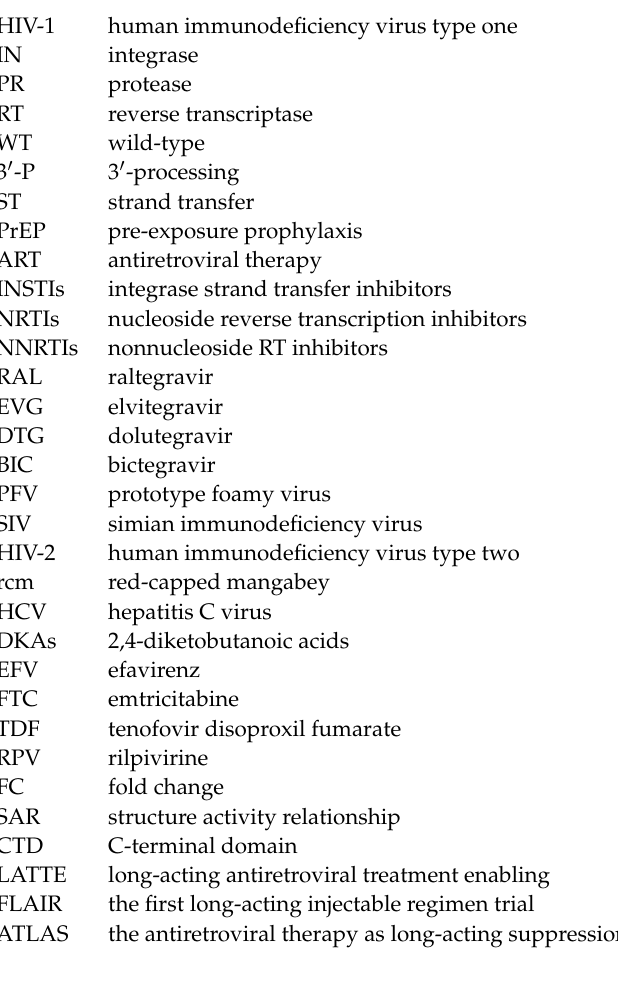
Table S1. Current recommendations for HIV-1 treatments with